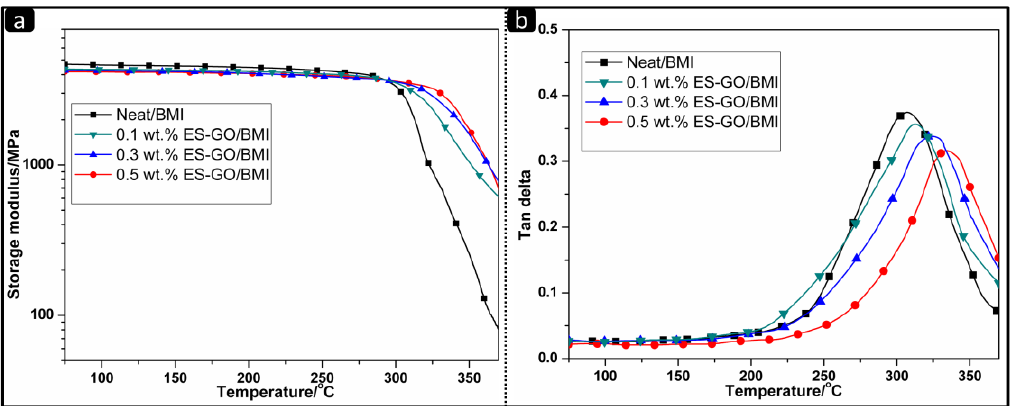
δ ( b ) of cured resin